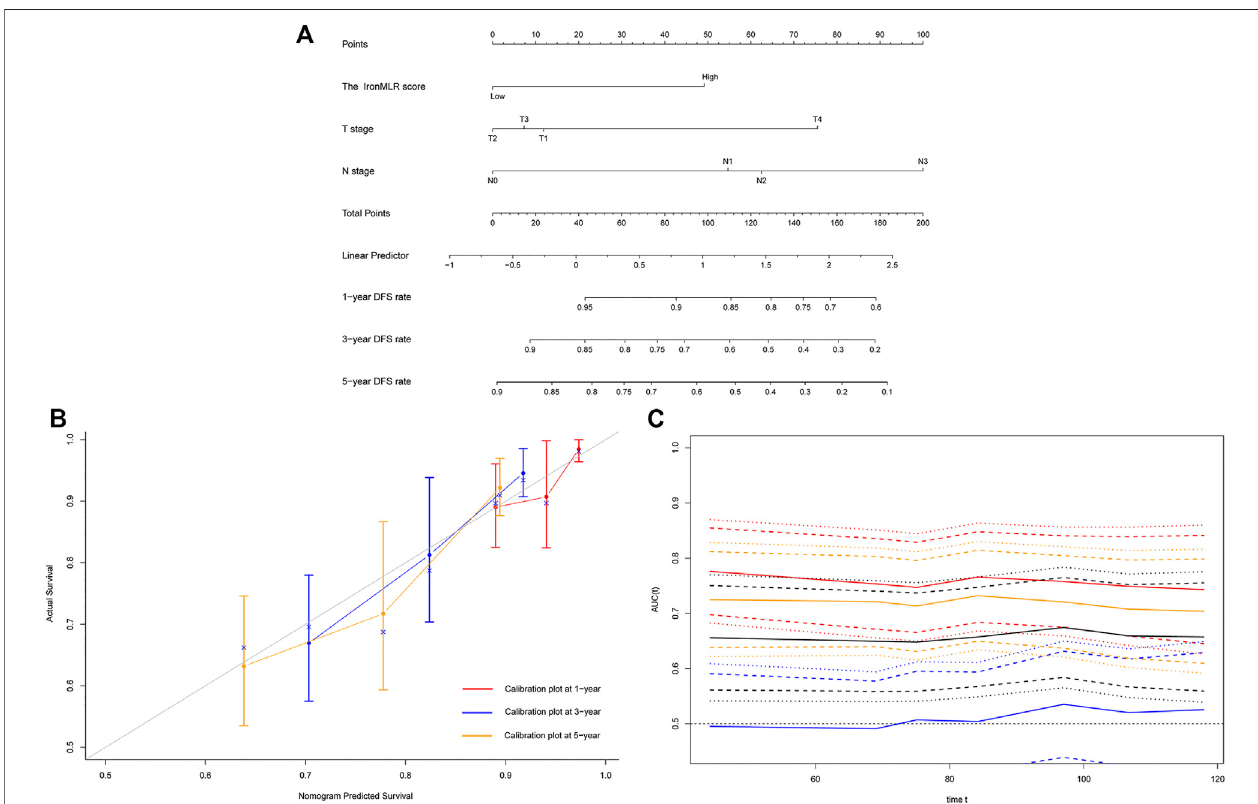
FIGURE3| Developmentandevaluationofamodelforindividualizedpredictionofdisease-freesurvival(DFS). (A) Nomogramofprognosticmodelforpatientswith early-stagetriple-negativebreastcancer. (B) Calibrationplotsof1-,3-,and5-yearsDFSpredictions. (C) Time-dependentreceiveroperatingcharacteristic(ROC)curves (Nomogram [red], T stage [blue], N stage [orange], TNM stage [black]).